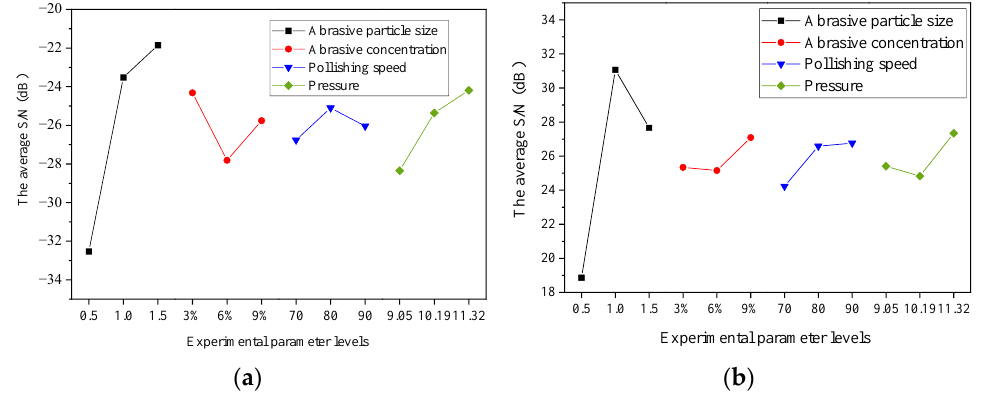
Figure 5. Effects of various factors on ( a ) R a and ( b ) MRR.